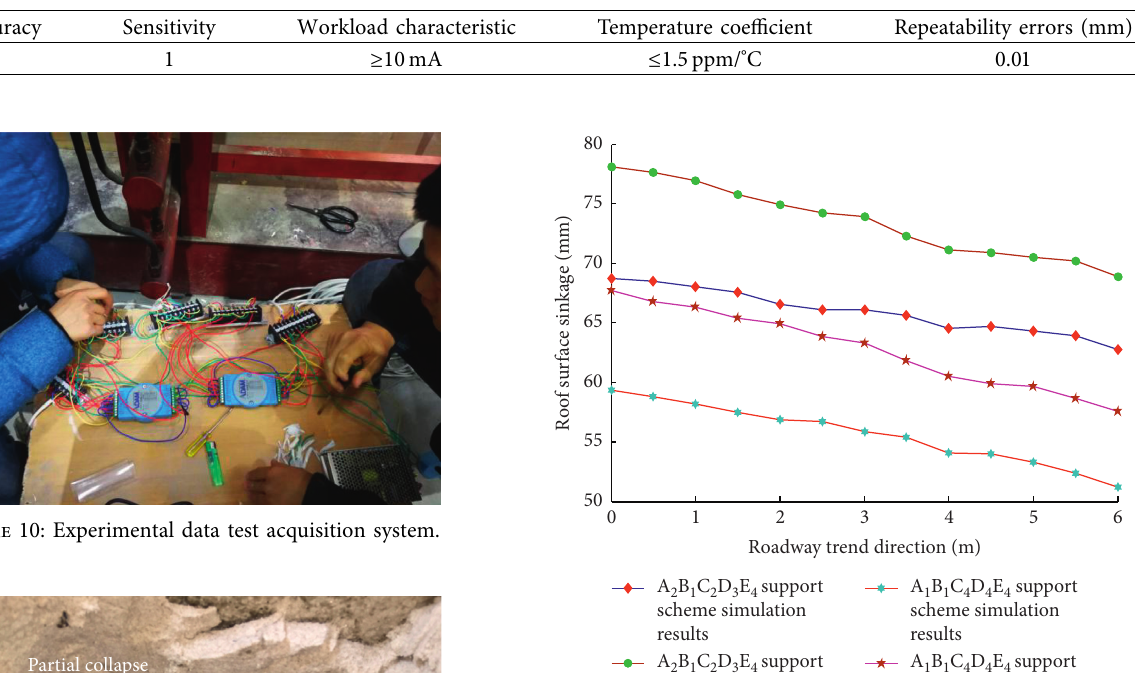
Table 6: Main technical parameters of KSP-25 displacement sensor.